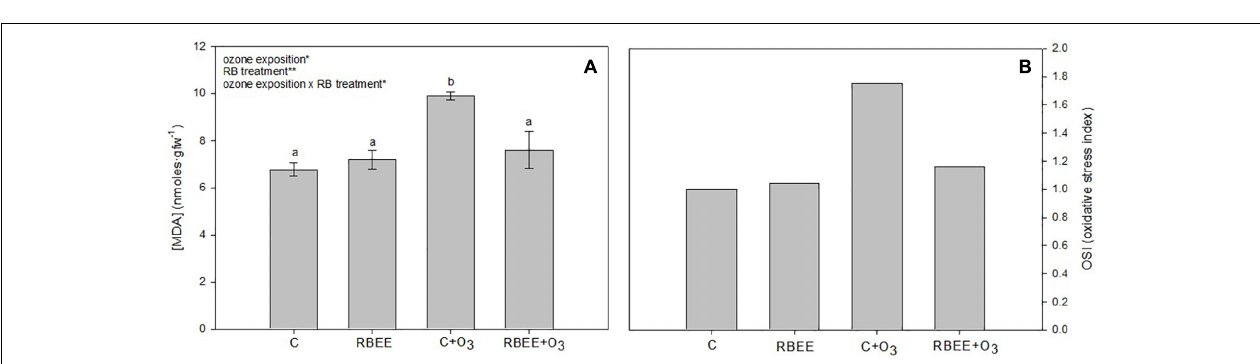
FIGURE 3 | Antioxidant enzyme activities. (A) Catalase (CAT), (B) ascorbate peroxidase (APX), (C) guaiacol peroxidase (GPX), and (D) superoxide dismutase (SOD) activities from leaves of pepper plants in response to two conditions of ozone (O 3 ) (0 and 100 ppm) under a treatment without and with rice bran enzymatic extract (RBEE). Values represent mean ± SD, n = 5. Different letters indicate means that are significantly different from each other (two-way ANOVA, O 3 exposition × RBEE treatment; HSD test, P < 0.05). O 3 exposition and RBEE treatment in the corner of the panels indicate main or interaction significant effects (* P < 0.01; ** P < 0.001; *** P > 0.0001).